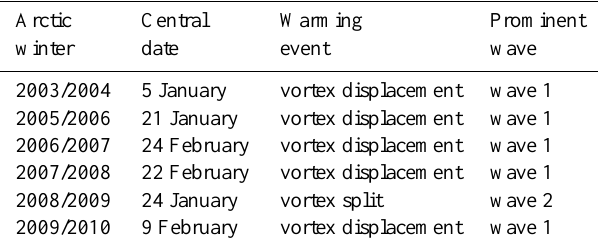
Table 1. Features of the MWs in recent Arctic winters. Central date (the day on which the westerlies changed to easterlies at 60 ◦ N/10hPa), whether the MW is vortex displacement or split event and prominent wave forcing are listed (data: the ECMWF op- erational